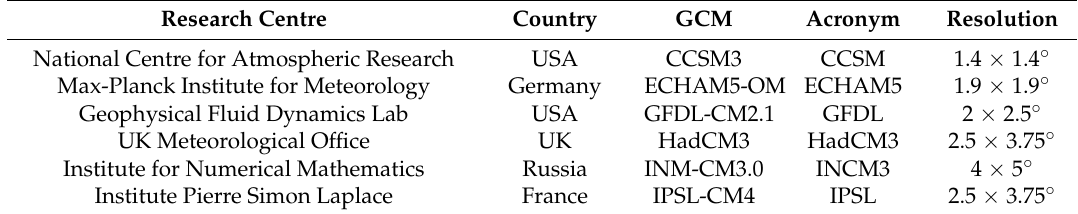
Table 2. The description of the GCMs (General Ciculation Models) and the IPCC-AR4 SRES (Special Report on Emission Scenarios) emission